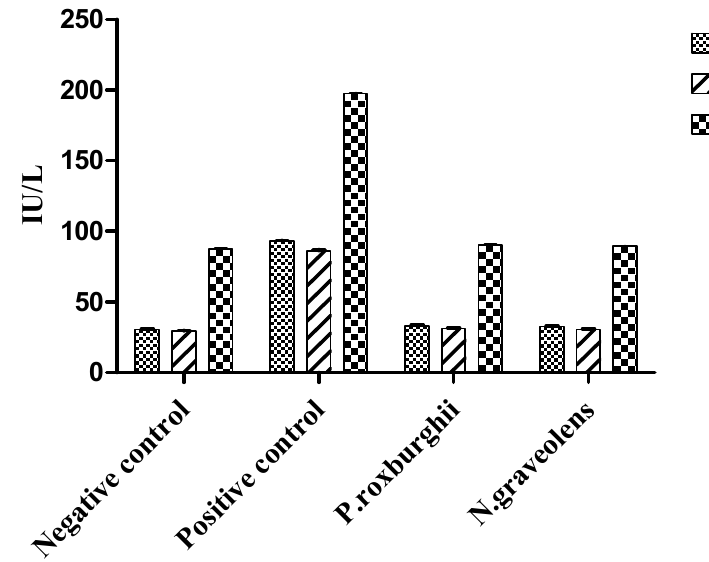
Figure 3. Serum ALT, AST, and ALP activities in different groups.